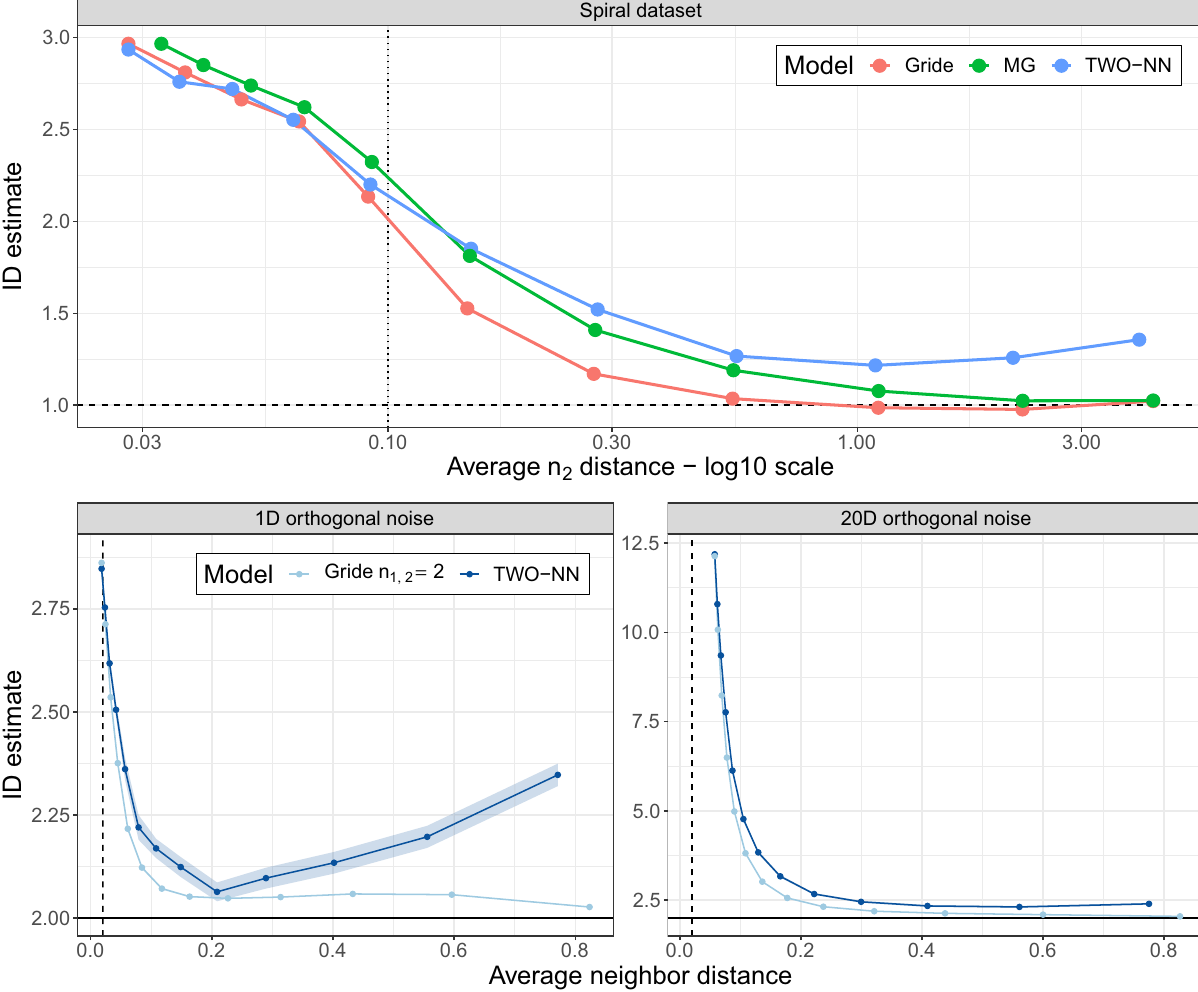
2 vs. the TWO-NN estimator = 2 std. err.) are visible only for one ±